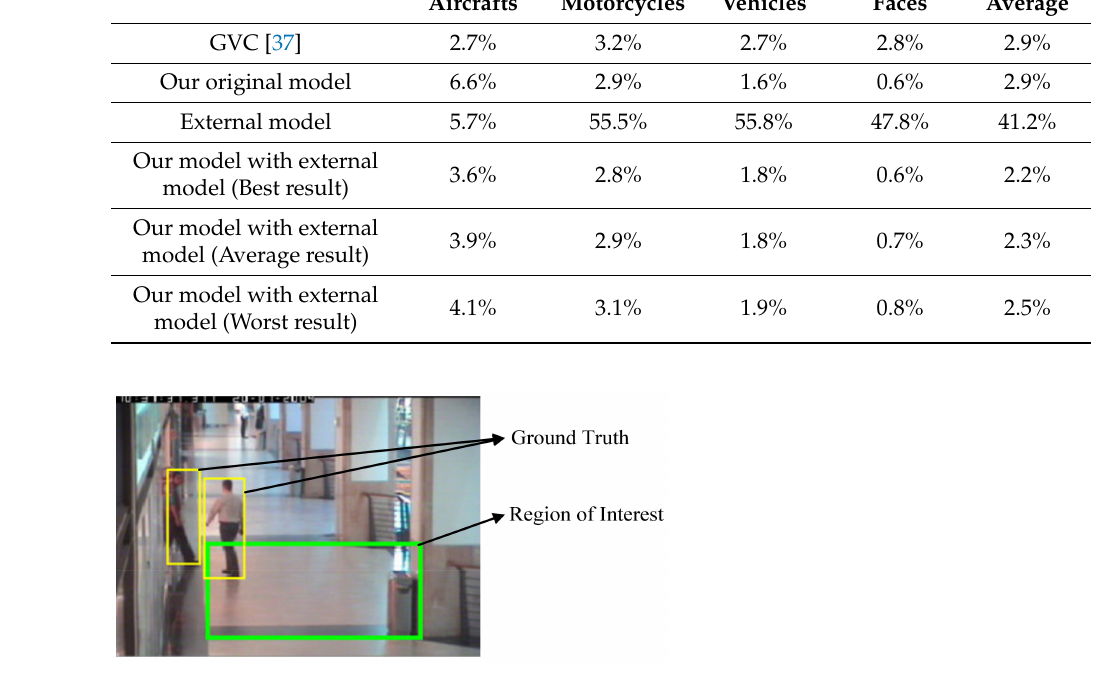
Figure 25. Region of interest. Table 8. Comparison results with other online learning algorithms in